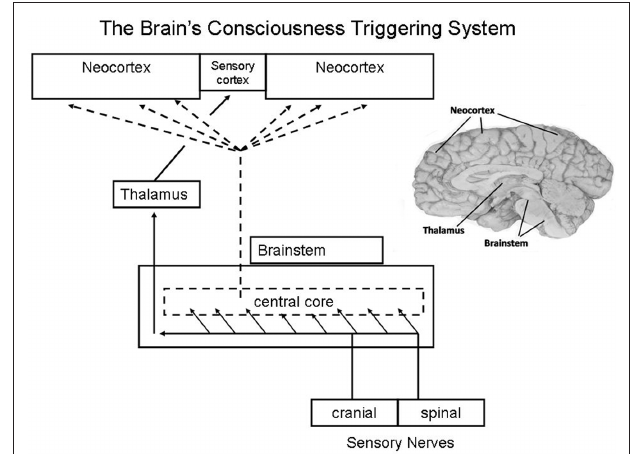
FIguRE 2 | Diagram of the traditional view of the function of the ascending reticular arousal system (ARAS), which provides a global activation of neocortex at the same time that somatic sensations are topographically routed via specific thalamic nuclei to the sensory cortex. Typically over-looked (and not illustrated here) are the feedback influences from neocortex to thalamus and brainstem reticulum. See comments below it item #6. (From